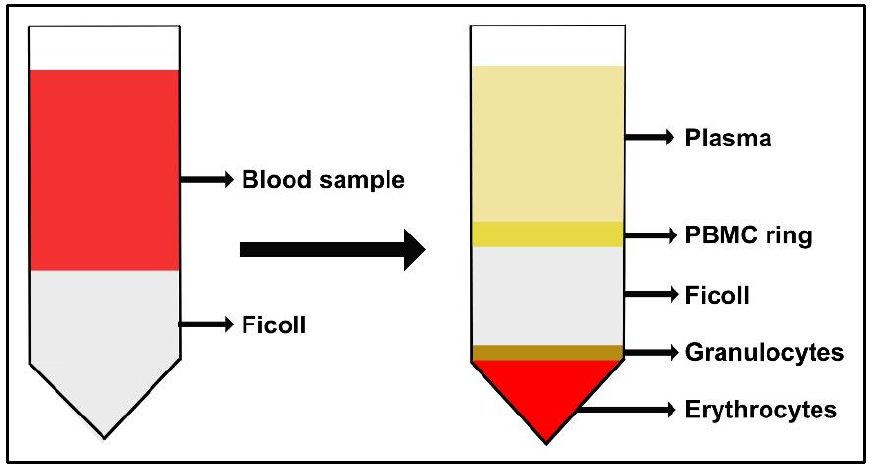
Figure 2. Schematic representation of the buffy coat sample stratified on Ficoll-Paque PLUS. After subsequent density gradient centrifugations, the PBMC ring layer is collected. Please note that red blood cells (RBCs) may be present in the cell suspension depending on the quality of PBMC isolation. If the number of RBCs makes it difficult to count PBMCs, RBCs may be lysed using an EDTA-based buffer.